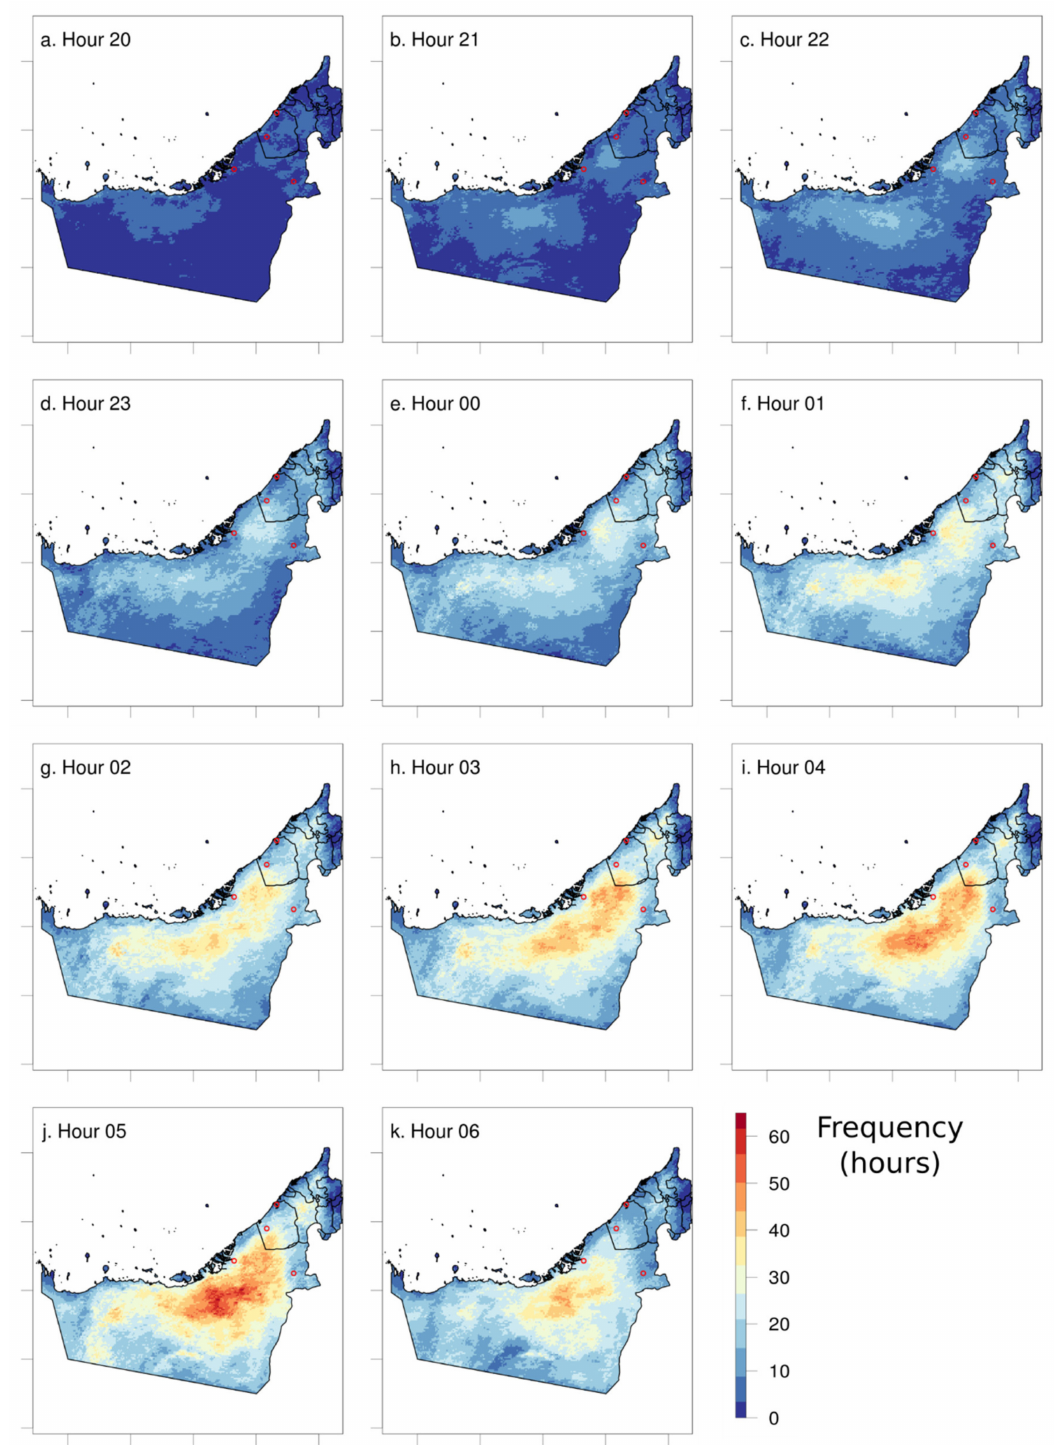
Figure 9. Hourly fog frequency from 20:00 h to 06:00 h local